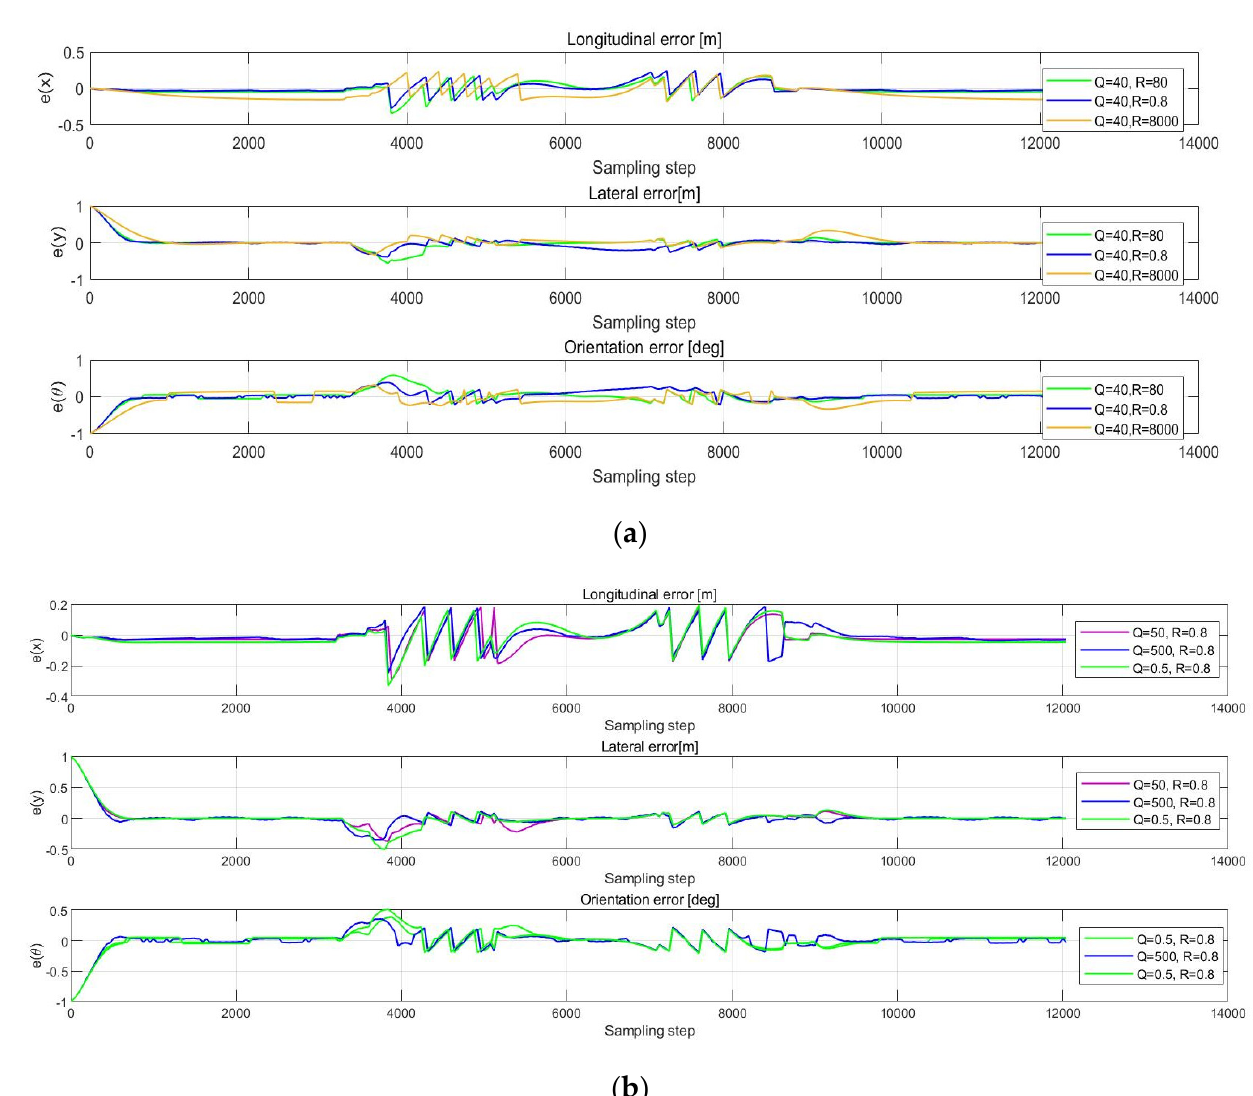
Figure 5. ( a ) Shows the comparison of trajectory errors after changing the weighting parameter R; Q = 40, R = 0.8 still achieves the best performance. ( b ) Compares trajectory errors after changing the weighting parameter Q; Q = 500, R = 0.8 still achieves the best performance. Figure 6a,b show the vehicle tracking heading performance and the longitudinal velocity. The yaw rate changes rapidly when passing through the curve